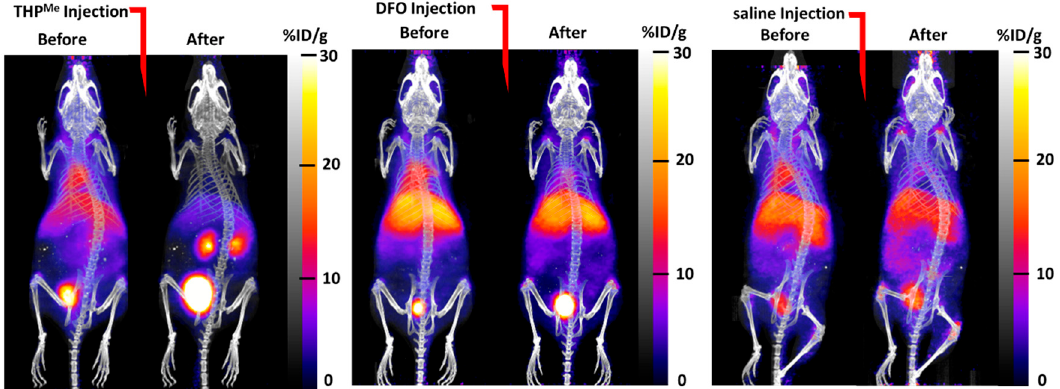
Figure 3. PET/CT maximum intensity projection (MIP) images of healthy mice injected with 68 Ga-acetate, followed at 1 h post injection by treatment with 24 nmol of THP Me (left pair of images), DFO (middle pair) or saline (right pair) as negative control (voxel size 0.21 × 0.21 × 0.21 mm 3 ).